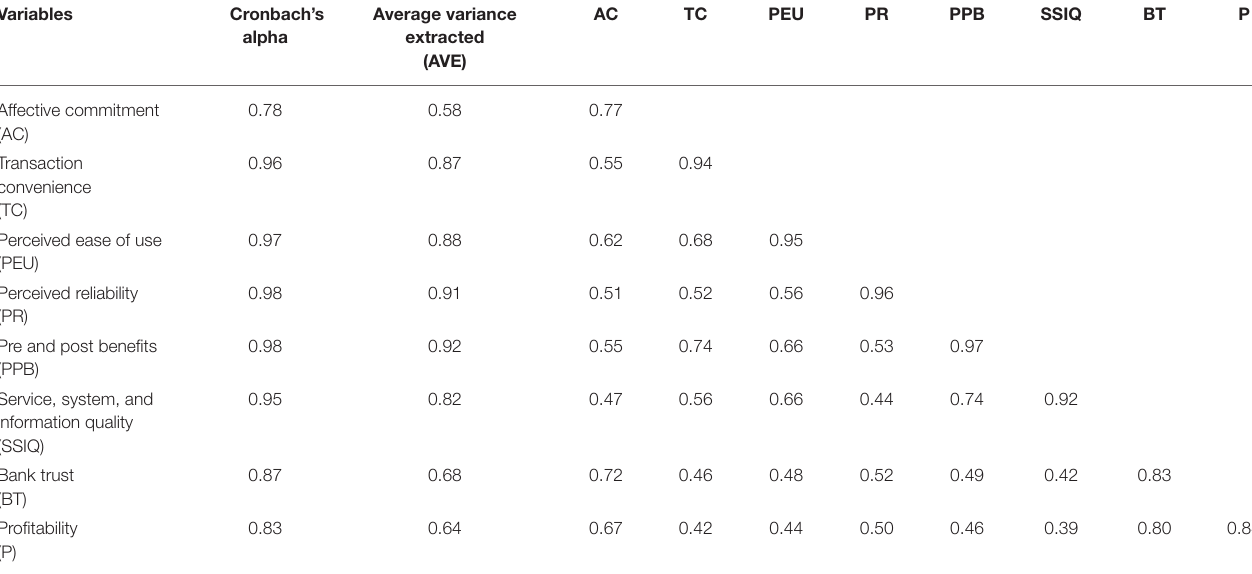
TABLE 4 | Hypothesis testing.